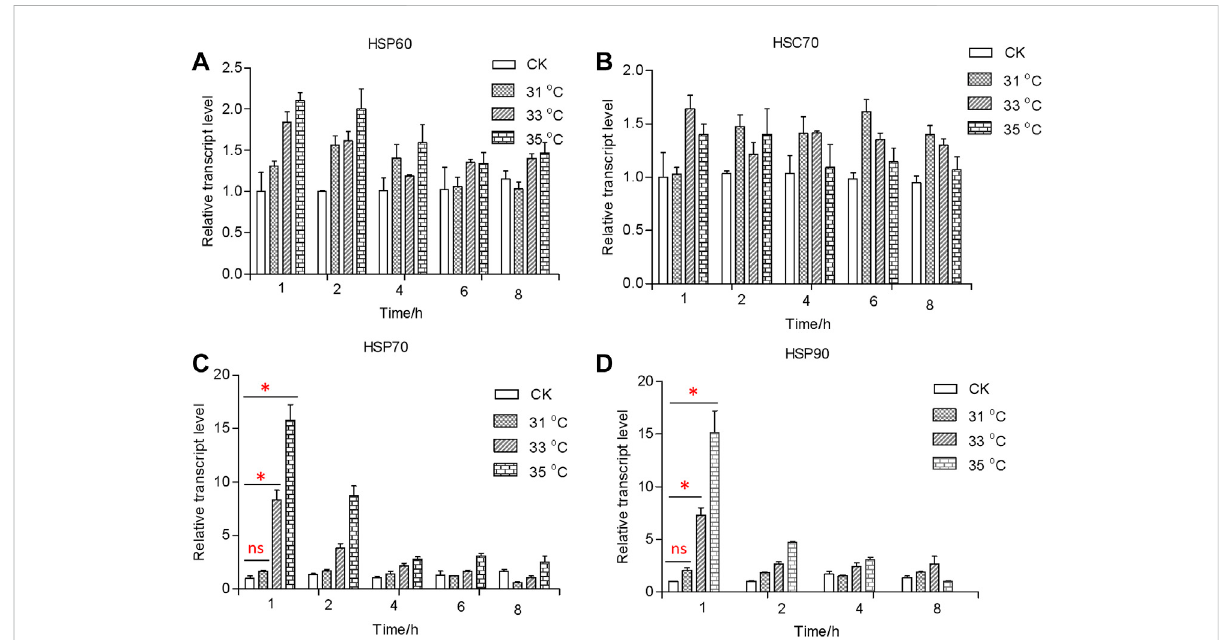
FIGURE 2 Relative transcript levels of HSP60 (A) , HSC70 (B) , HSP70 (C) , and HSP90 (D) under different temperatures. Relative mRNA levels wereanalyzed using the 2 − Δ Δ CT method. All values from two independent replicates are shown as the mean ± SD. The data ( HSP70 and HSP90 ) between CK (27 C) and other treatments (31/33/35 C) at 1 h were analyzed by ANOVA. “ * ” stands for a signi fi cant difference ( p < 0.05) between CK (27 C) and other treatments; “ ns ” is not signi fi cant.